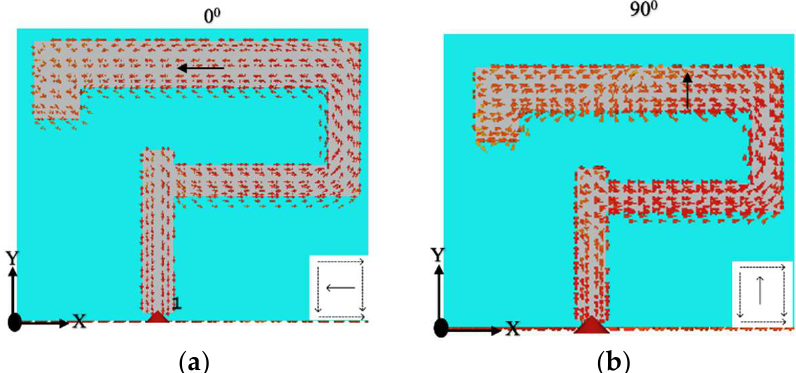
Figure 9. AR ratio of the CP 5G RDR with different ground plane sizes.